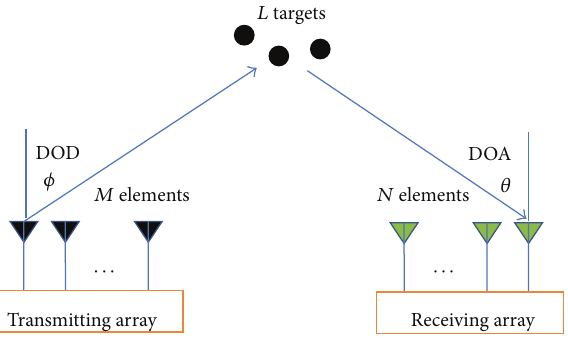
Figure 1: Overview of angle estimation in MIMO radar.